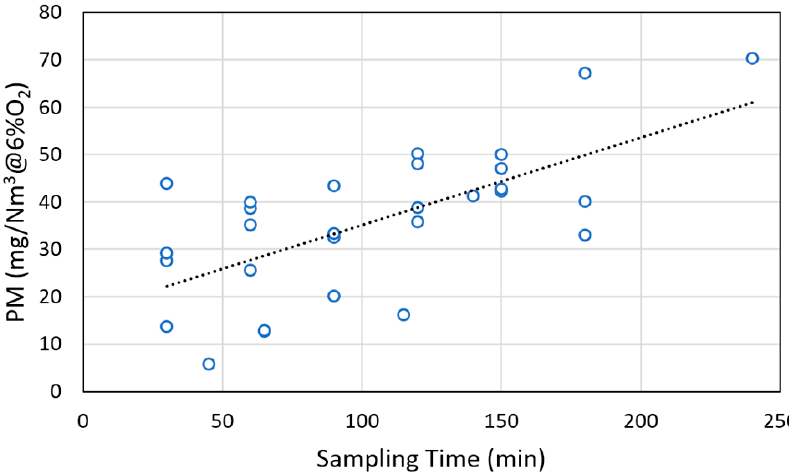
Figure 2. Particulate matter (PM) concentration as a function of the sampling moment (minutes after stability). Tests conditions φ = 20%, (cid:1865)(cid:4662) (cid:3028)(cid:3036)(cid:3045)(cid:4593)(cid:4593) = 0.457 kg/m 2 s and wp2.